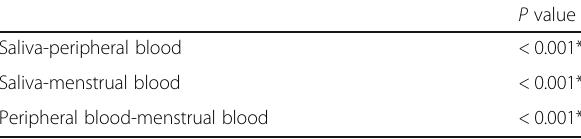
Table 5 Pairwise comparisons between XIST mean values in the studied female body